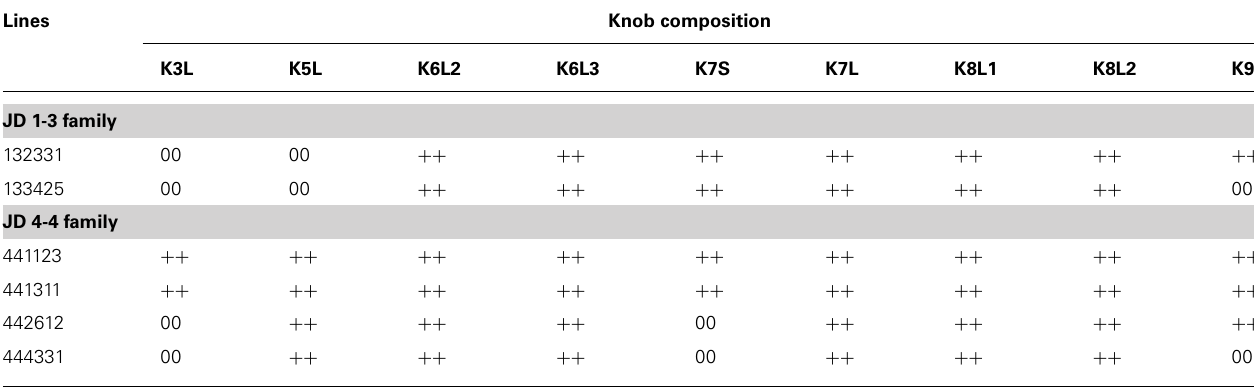
Table 1 | JD 1-3 and JD 4-4 line families analyzed and their knob compositions visualized in pachytene chromosomes. Lines Knob